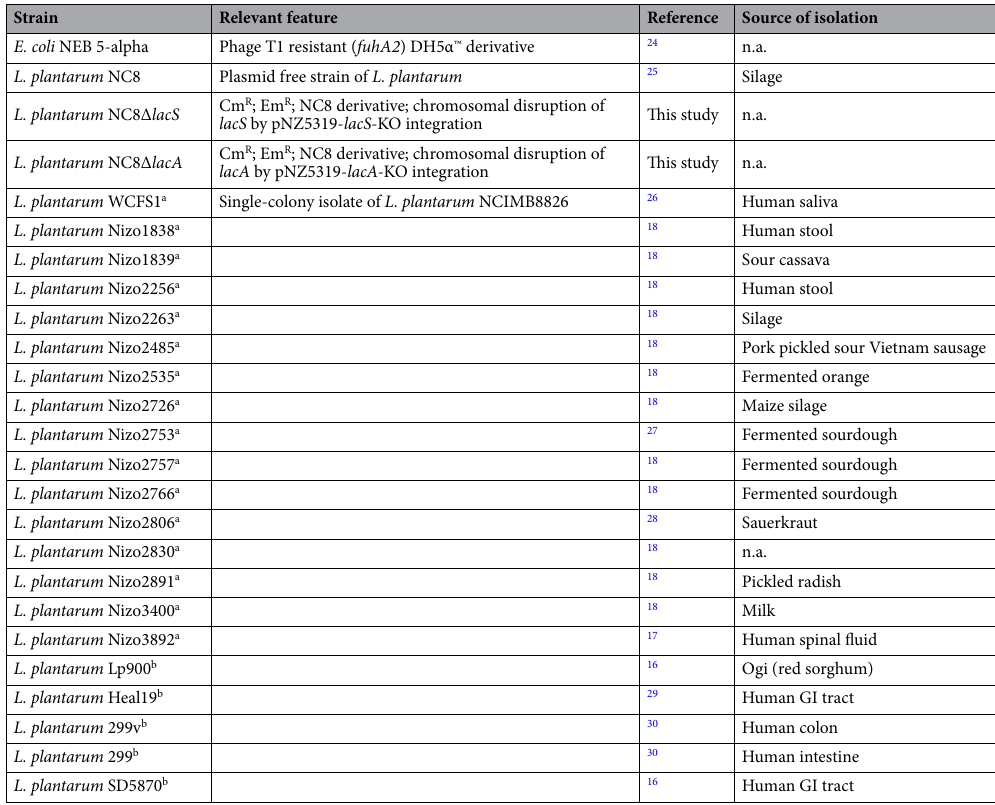
Table 1. Strains used in this study. a Nizo strain collection, b Probi A/B strain collection. n.a. not